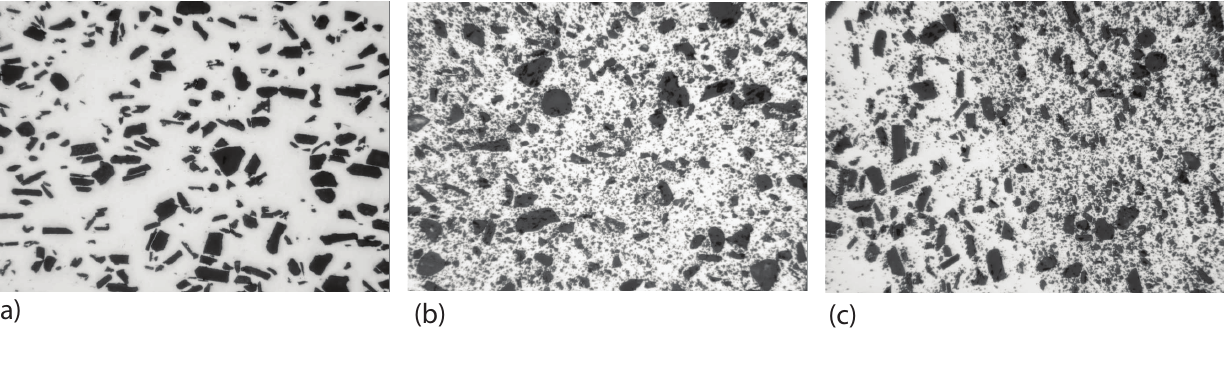
Figure 5 . Effect of friction stir processing on the distribution of alumina particles in 6061 aluminum alloy (after Marzoli et al. [60]): (a) micrograph showing the composite before FSP; (b) micrograph showing the composite after FSP; (c) microstructure transition near the nugget zone.